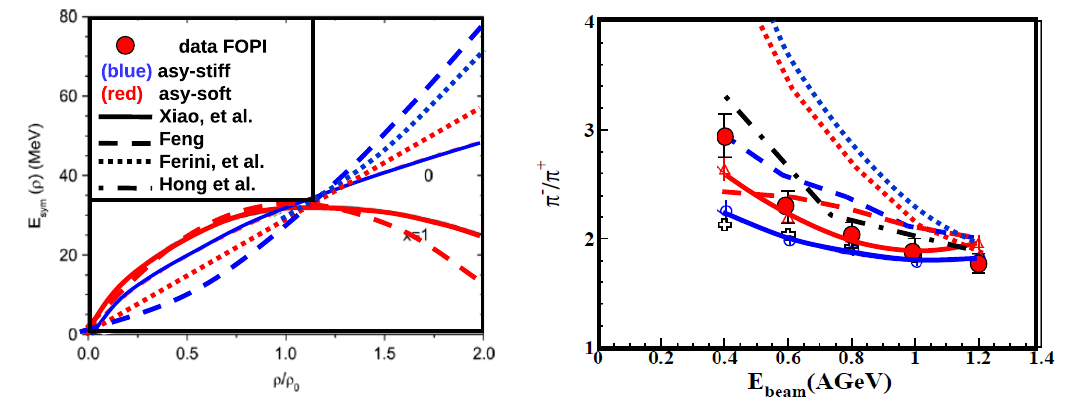
Figure 8. ( Right ) The π − / π + ratio in Au + Au collisions as a function of incident energy as measured by the FOPI collaboration and calculated by different groups, as indicated in the legend of the left panel and discussed in the text. The blue and red lines refer to the softer and stiffer symmetry energies, respectively, used in the different models, which are identified by the signature of the line. ( Left ) This panel shows the density dependence of the symmetry energy used in the models. Figure taken from